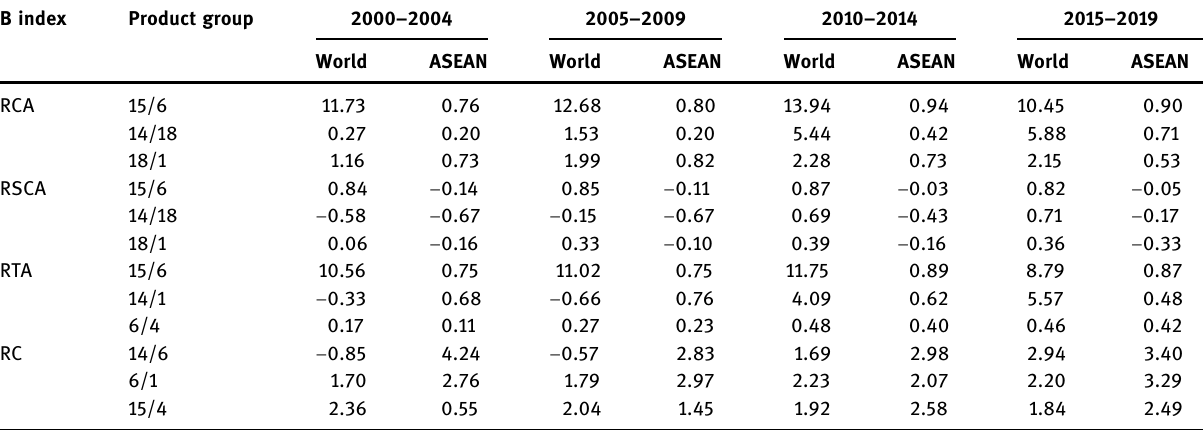
Table 8: The three highest Balassa indices of Malaysia at World and ASEAN level, 2000 –